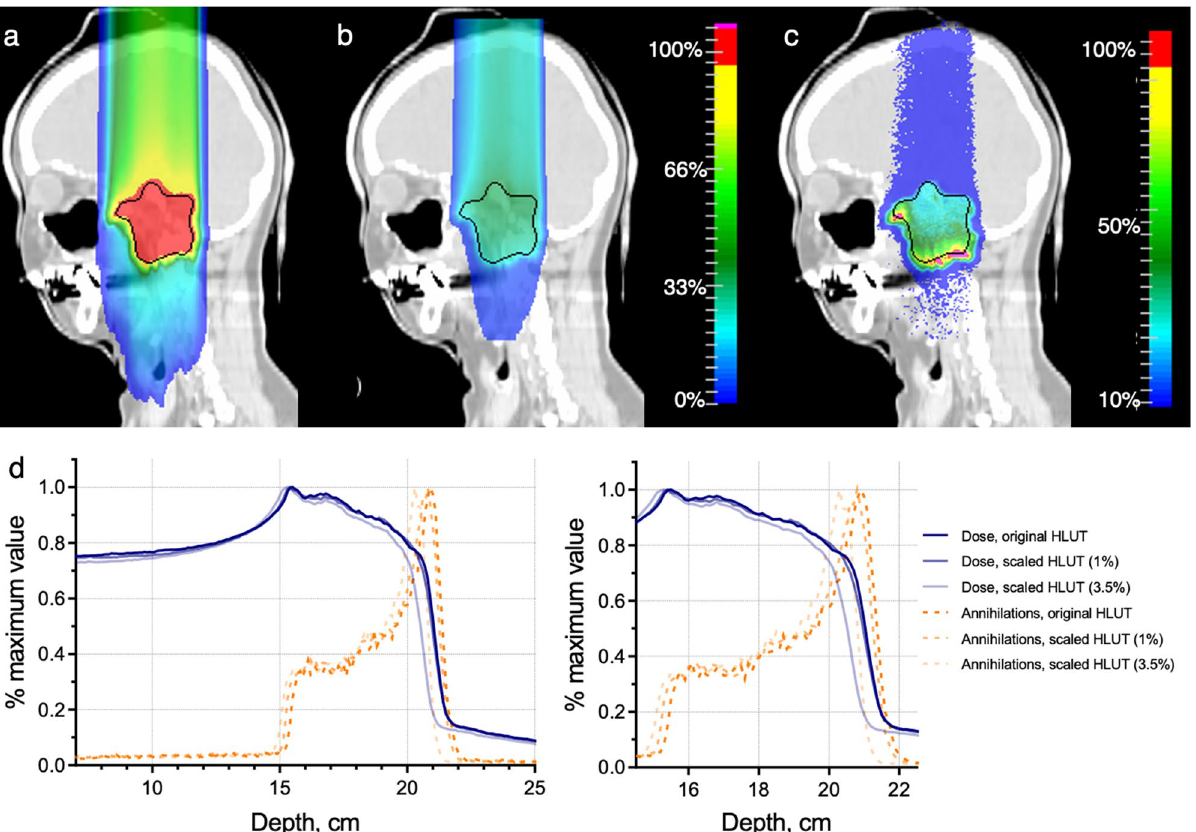
Figure 1. Dose and activity distributions calculated in a patent CT. ( a ) RBE-weighted dose map calculated with TRiP98, ( b ) absorbed dose and ( c ) annihilation maps calculated with FLUKA for a single-field 11 C treatment plan optimized in a patient CT. Color bars reflect the respective distributions with red corresponding to the maximum observed values. ( d ) Normalized beam-eye-view profiles extracted from the dose and annihilation maps for the original treatment plan and those optimized using the scaled HLUT tables (for 3.5% or 1%) to mimic the range uncertainties. Depth is given in the CT coordinates. Blue solid lines: dose profiles, orange dashed lines – annihilation profiles. Left plot is a zoom-in of the distributions in the target